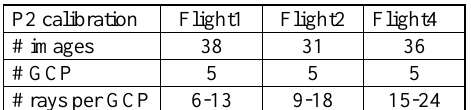
Table 2. Case P2 – “on-the-job” calibration blocks